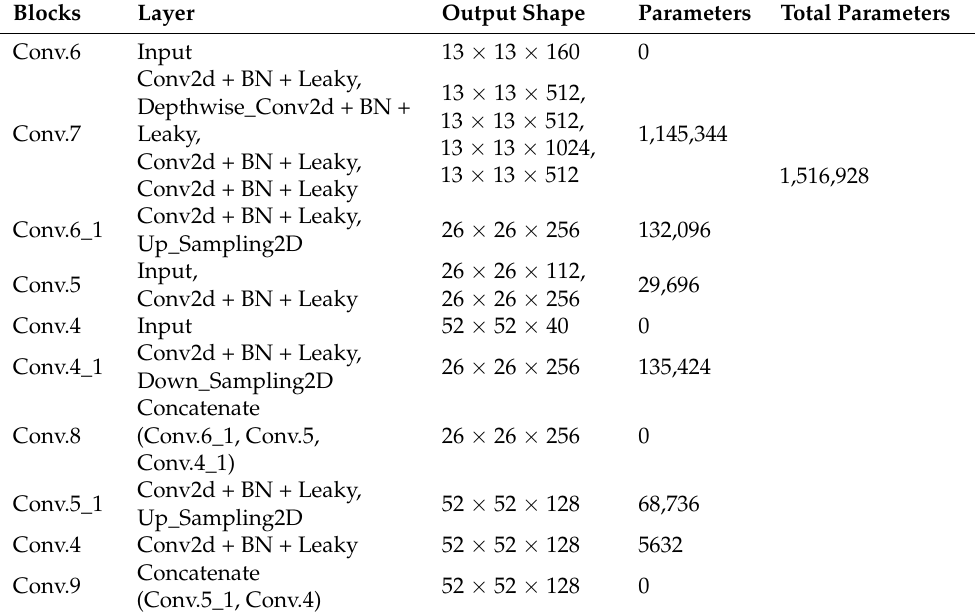
Table 4. Details of the processes in Step